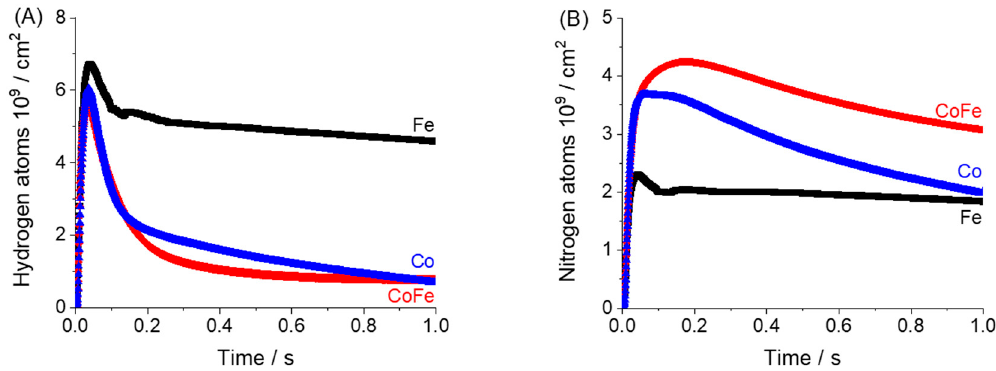
Figure 9. Dynamic atomic accumulation calculated from pulse response data for ( A ) hydrogen and ( B ) nitrogen when ammonia is pulsed over Fe, CoFe and Co at 550 °C.